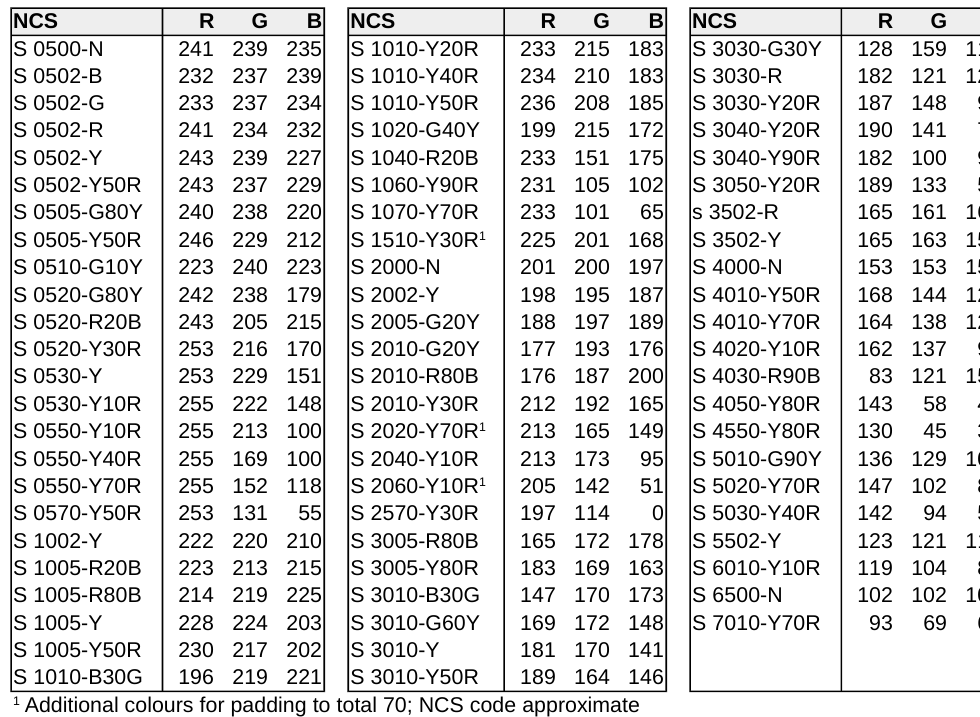
Table A1. Candidate colours selected for printing on glass, along with their corresponding RGB print